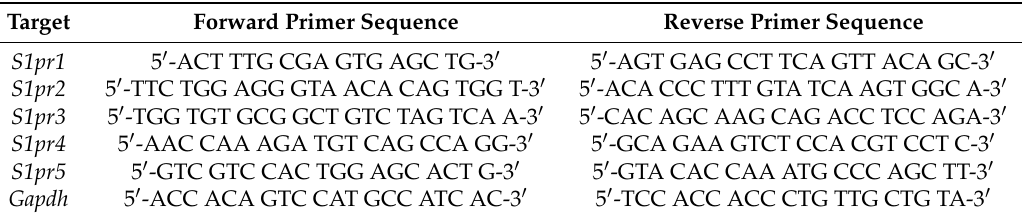
Table 1. Quantitative real-time-(RT-)PCR was run on an Applied Biosystems StepOnePlus Real-Time PCR System (Thermo Fisher Scientific, Ottawa, ON, Canada). Table 1. Quantitative RT-PCR primers for mouse